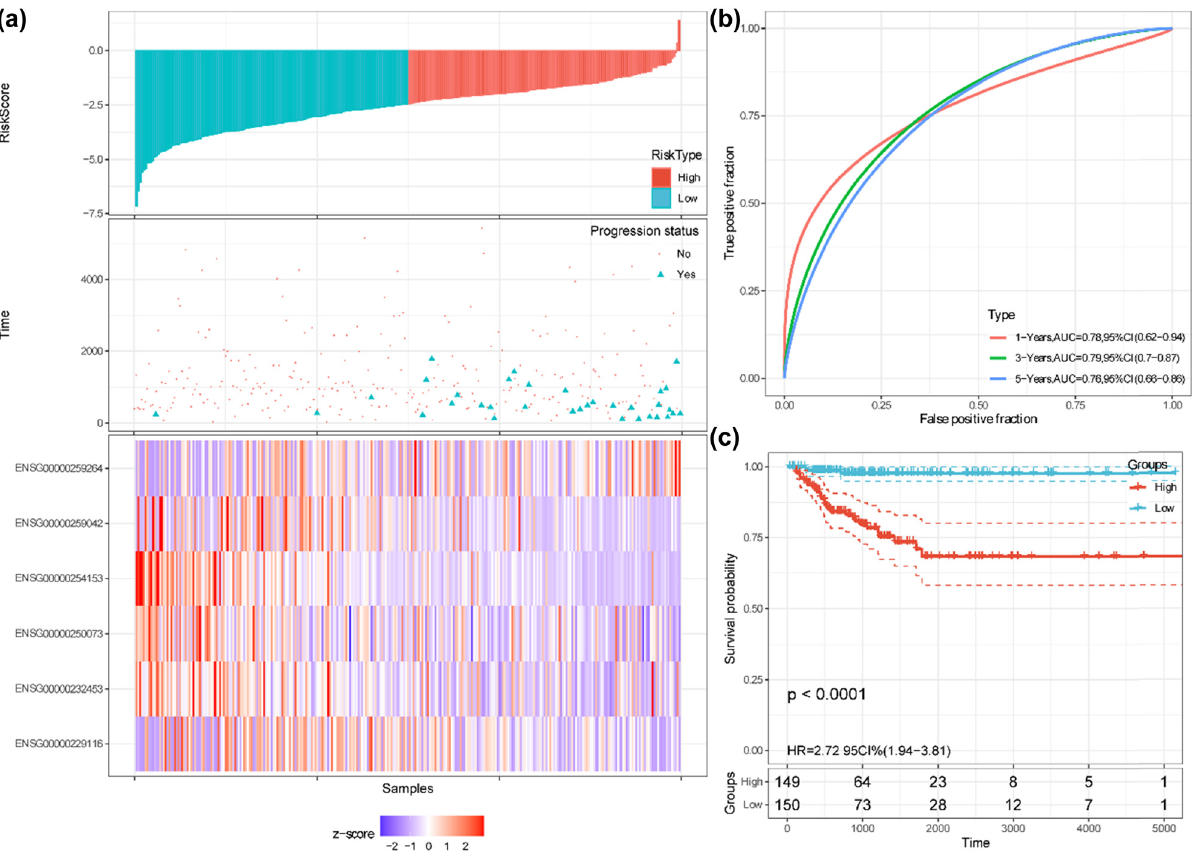
Figure 5: Predictive performance of the six autophagy - related lncRNAs signature in the training cohort. ( a ) Risk scores, PFI/progression status, and expression heatmap. ( b ) Time - dependent ROC curves for predicting 1 - , 3 - , and 5 - year PFI based on the risk scores. ( c ) Kaplan – Meier curves of the patients with high and low - risk scores, which were divided by the median